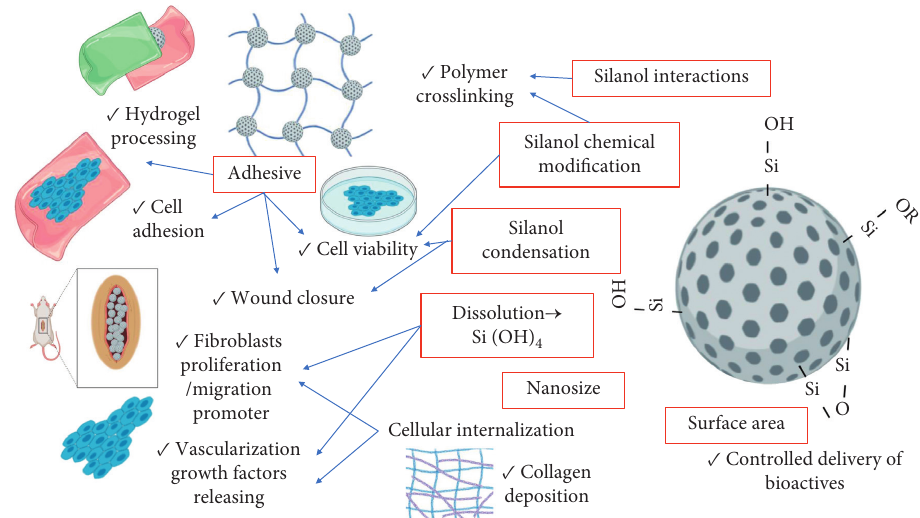
Figure 2: Silica properties (red squares) and biological responses on wound healing and wound dressings